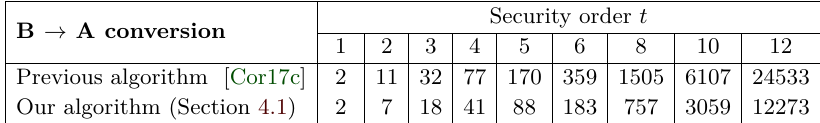
Table 3: Number of random generations for Boolean to arithmetic conversion algorithms from [Cor17c] and this paper, up to security order t = 12, with n = t + 1 shares. B → A